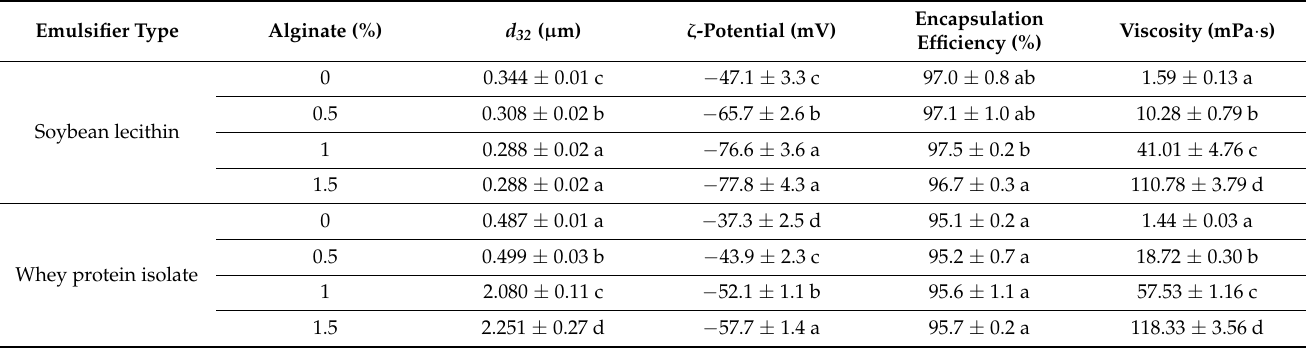
Table 1. Initial characterization of soybean lecithin and whey protein isolate curcumin-loaded nanoemulsions containing different sodium alginate concentrations.